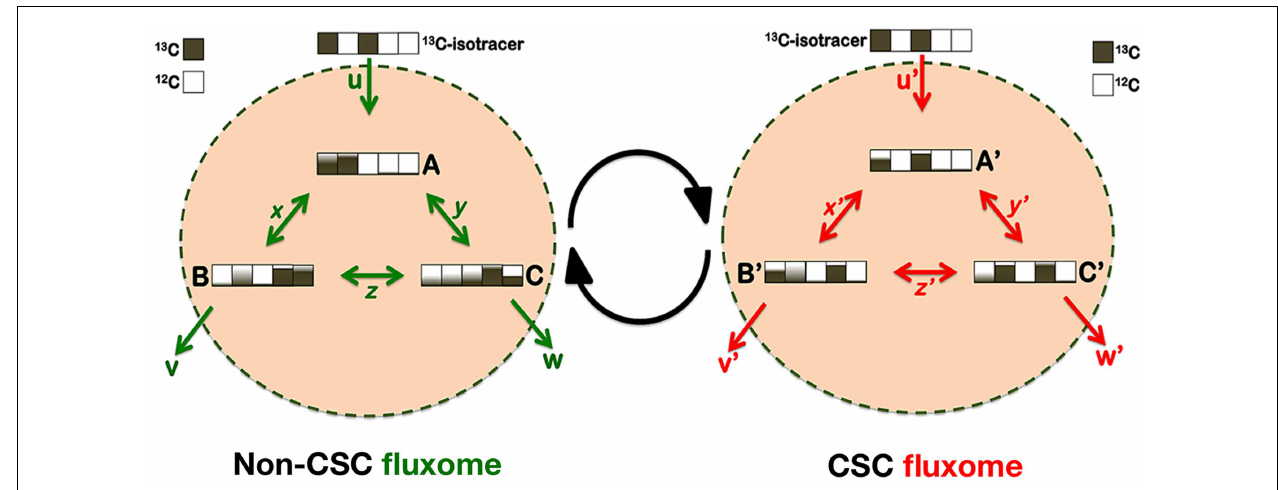
imprint of labeling patterns whose mass signature will be observed by MS. All fluxes can be determined on an absolute scale because the physiological fluxes in and out of non-CSC and CSC cells will be available under experimental conditions. Mass isotopomers can be analyzed at different times to follow the label incorporation immediately after incubating cells with a labeled substrate.To translate the time-series labeling data into metabolic fluxes, MS-related mathematical models could combine the balances of the total metabolite pools and of individual isotopomers to obtain complete information about the transitions of the labeled carbons within metabolites. The model inputs will be the isotopomer 13 C time-courses and some metabolite pools determined experimentally, in addition to the consumption or production rates of metabolites measured in cell supernatants. Because the isotopic transient 13 C-MFA methodology does not rely on uncertain cofactor balances it allows the estimation of fluxes through both parallel and cyclic pathways as well as through bidirectional